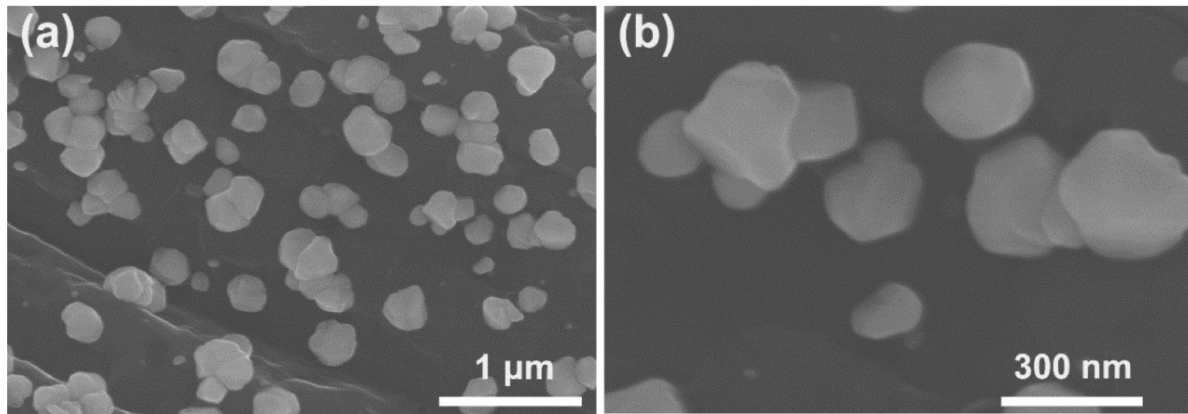
Figure 1. ( a ) Low-magnification scanning electron microscope (SEM) image and ( b ) high-magnification SEM image of Pd particles electrodeposited for 2700 s at − 0.15 mA cm − 2 (Pds −